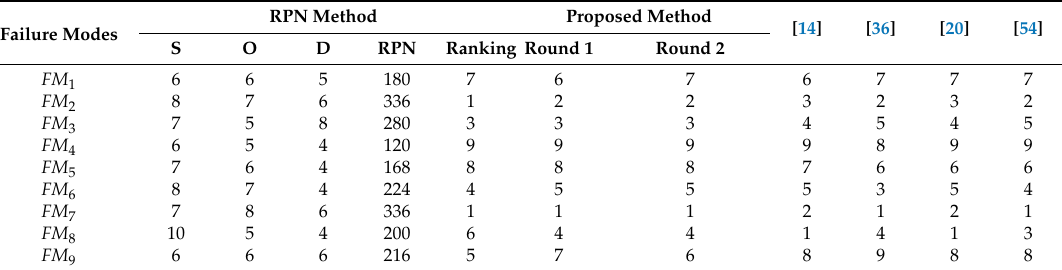
Table 6. Ranking of failure modes of different